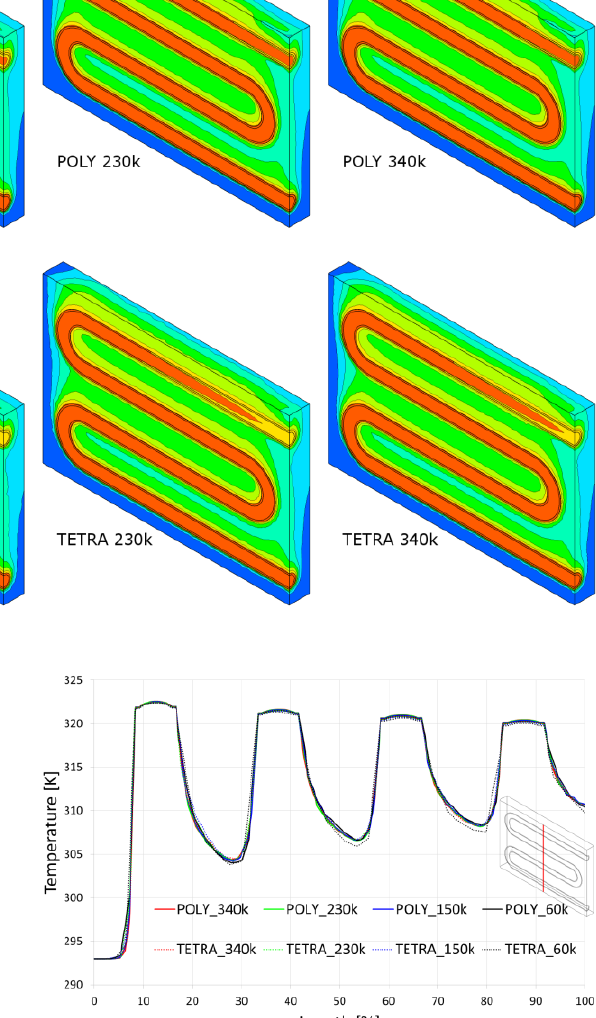
Fig. 10. Temperature along the centerline of the heat exchanger